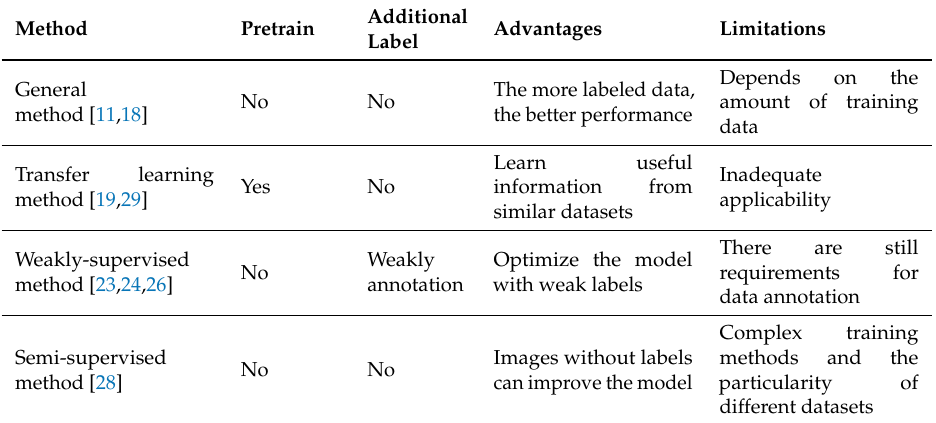
Table 1. Comparison of image segmentation